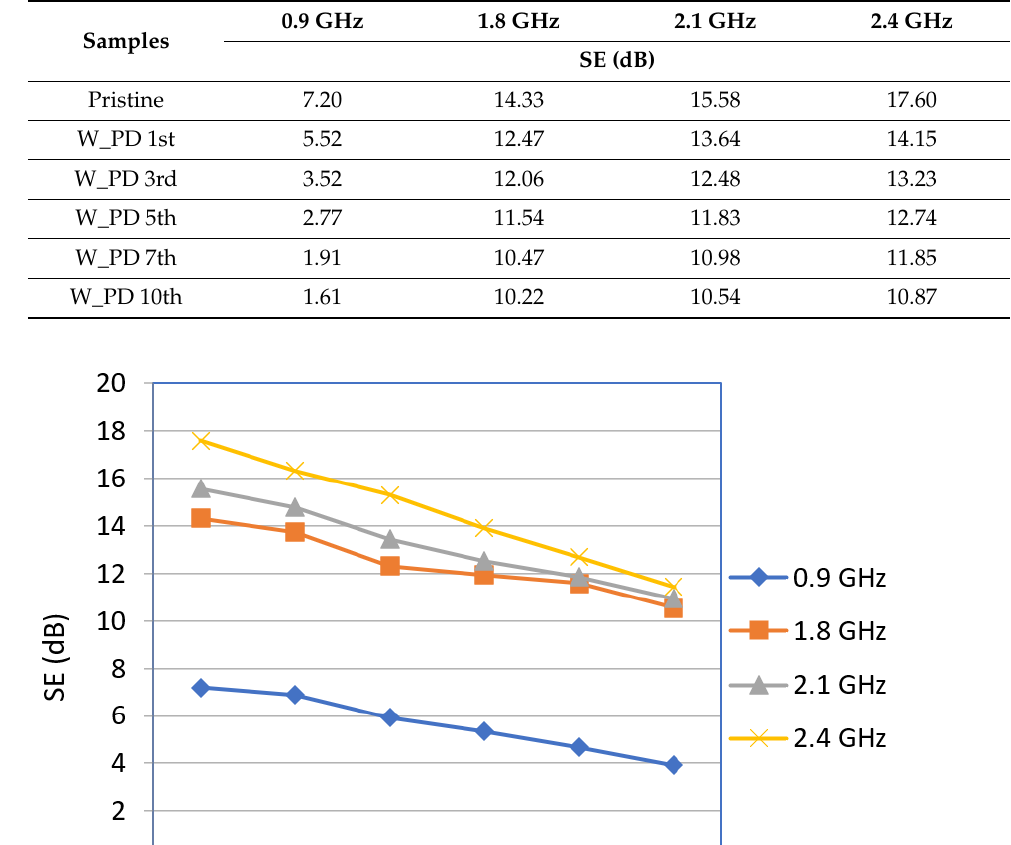
Table 6. Shielding effectiveness (EMSE) of sample of stainless-steel fabric (face) before and after the 1st, 3rd, 5th, 7th, and 10th washing cycles with powder detergent at frequencies 0.9 GHz, 1.8 GHz, 2.1 GHz, and 2.4 GHz.